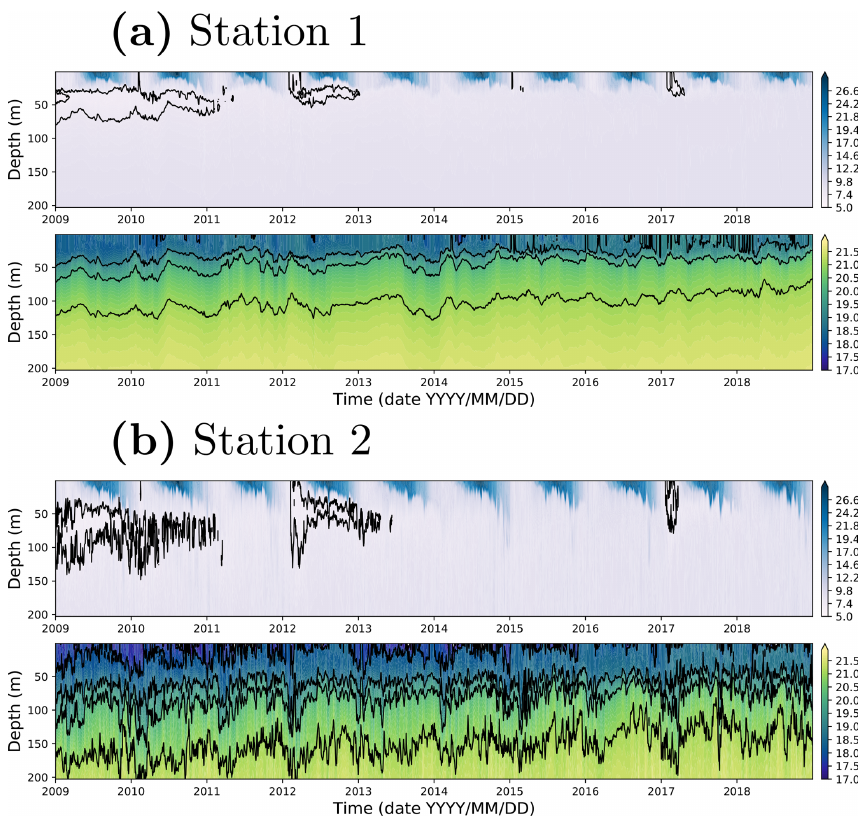
Figure 14. Time series of temperature and salinity versus depth at (a) station 1 and (b) station 2 of Fig.